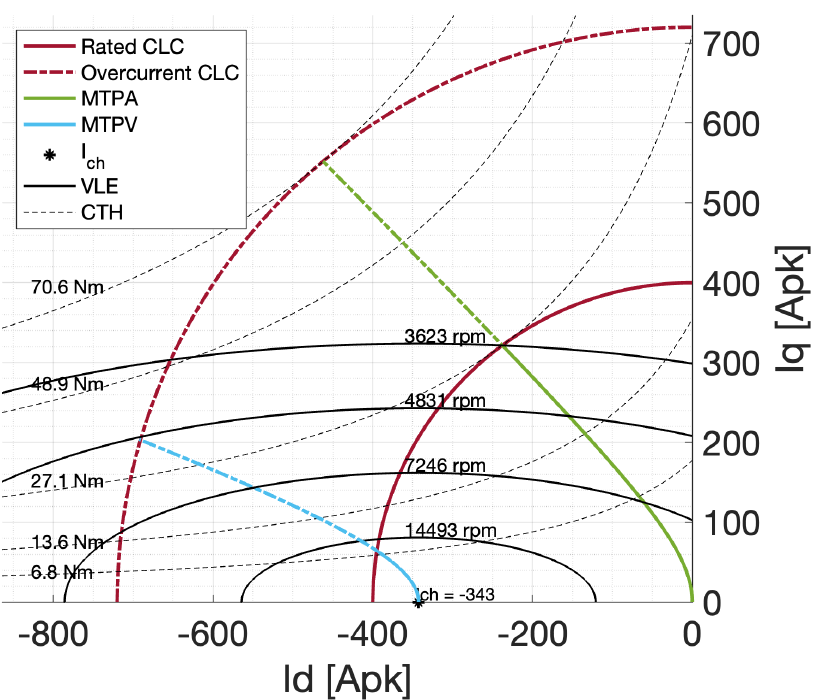
Figure 11. Control trajectories on the d-q plane computed with the conventional linear model. MTPA and MTPV curves are reported in the same figure for FP and Standard Method (Figure 12): MTPA trajectory computed with FP is more tilted towards the negative d -axis, underlining a better capability of such method to detect the correct behaviour of the machine when saturation starts to be non-negligible. Figure 13 highlights the differences between the two methods for the Voltage Limit Ellipse (computed at base speed) and the Constant Torque Hyperbola (computed at rated